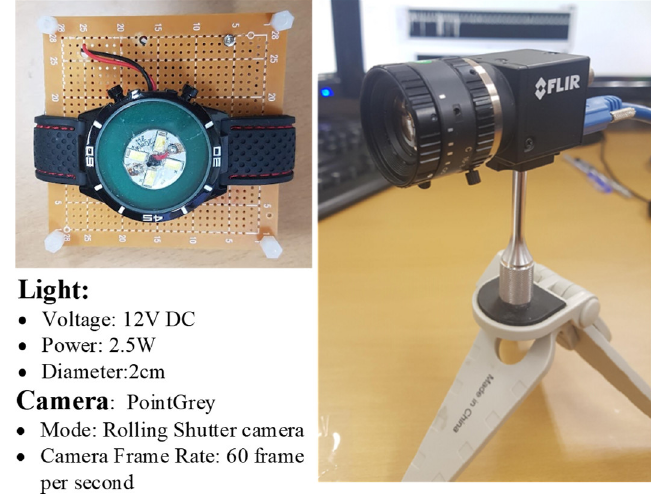
Figure 5. The device for the SNR measurement.